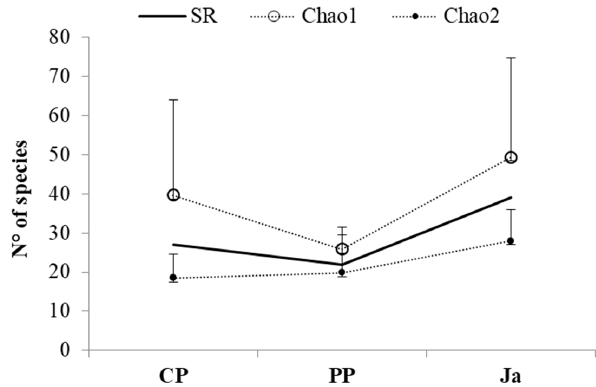
Figure 3. Comparison between the species richness (SR) observed in every site (CP Cabo de Palos, PP Punta Prima and Ja Jávea) and the species richness expected by using the non-parametric estimator Chao 1, for abundance data, and Chao 2, for replicated incidence data (dots with S.D. bars).